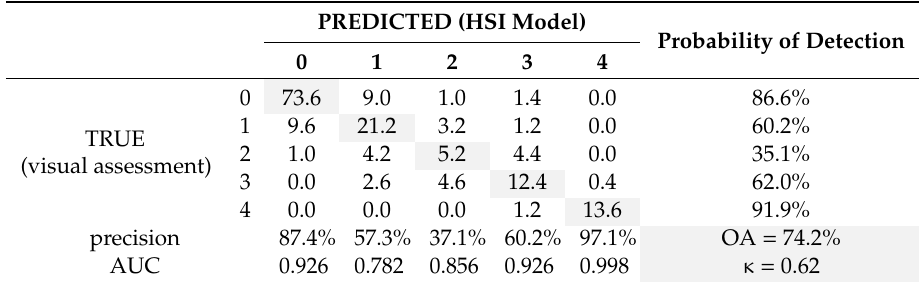
Table 1. Confusion matrix for vigor groupings classification between TRUE classes (from visual assessments) and PREDICTED classes (from hyperspectral imaging model) averaged over five dates, 0 = non-inoculated control seedlings, 1 = infected & vigorous, 2 = infected and moderately vigorous, 3 = infected and sickly, 4 = infected and dead. Probability of detection is the number of correct labels divided by the total number of observed seedlings in that class; precision is the number of correct labels divided by the total predicted seedlings in that class; AUC is the average area under the curve for a receiver operating characteristic curve for that class versus the rest; OA is the overall accuracy, and; κ is the kappa coe ffi cient. The table points out that seedlings in vigor-class 2 were di ffi cult to separate from classes 1 and 3.